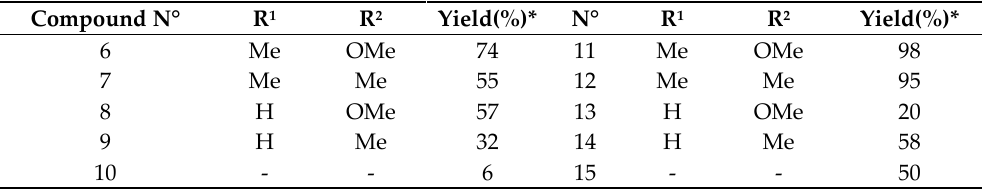
*Isolated by column